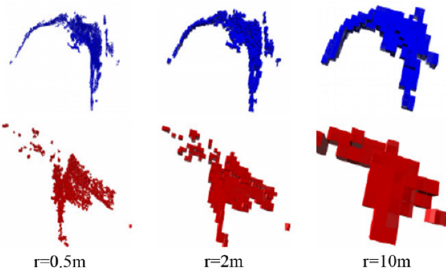
Figure 5. Multi-resolution maps, where r is the resolution of the 3D model. The blue ones are the global model maps, and the red ones are the local scan maps, three different resolution levels (0.5 m, 2 m and 10 m) are listed in this figure.